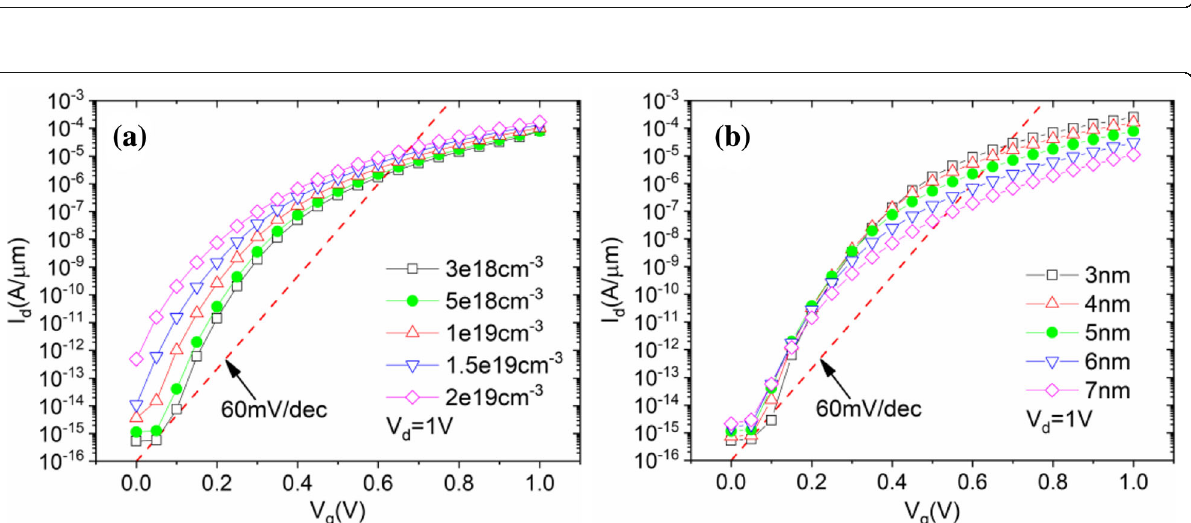
Fig. 5 3D schematic diagram of electric fields of the device a with overlap and b without overlap; simulated c energy band diagrams from source to pocket region (1 nm below the oxide interface)